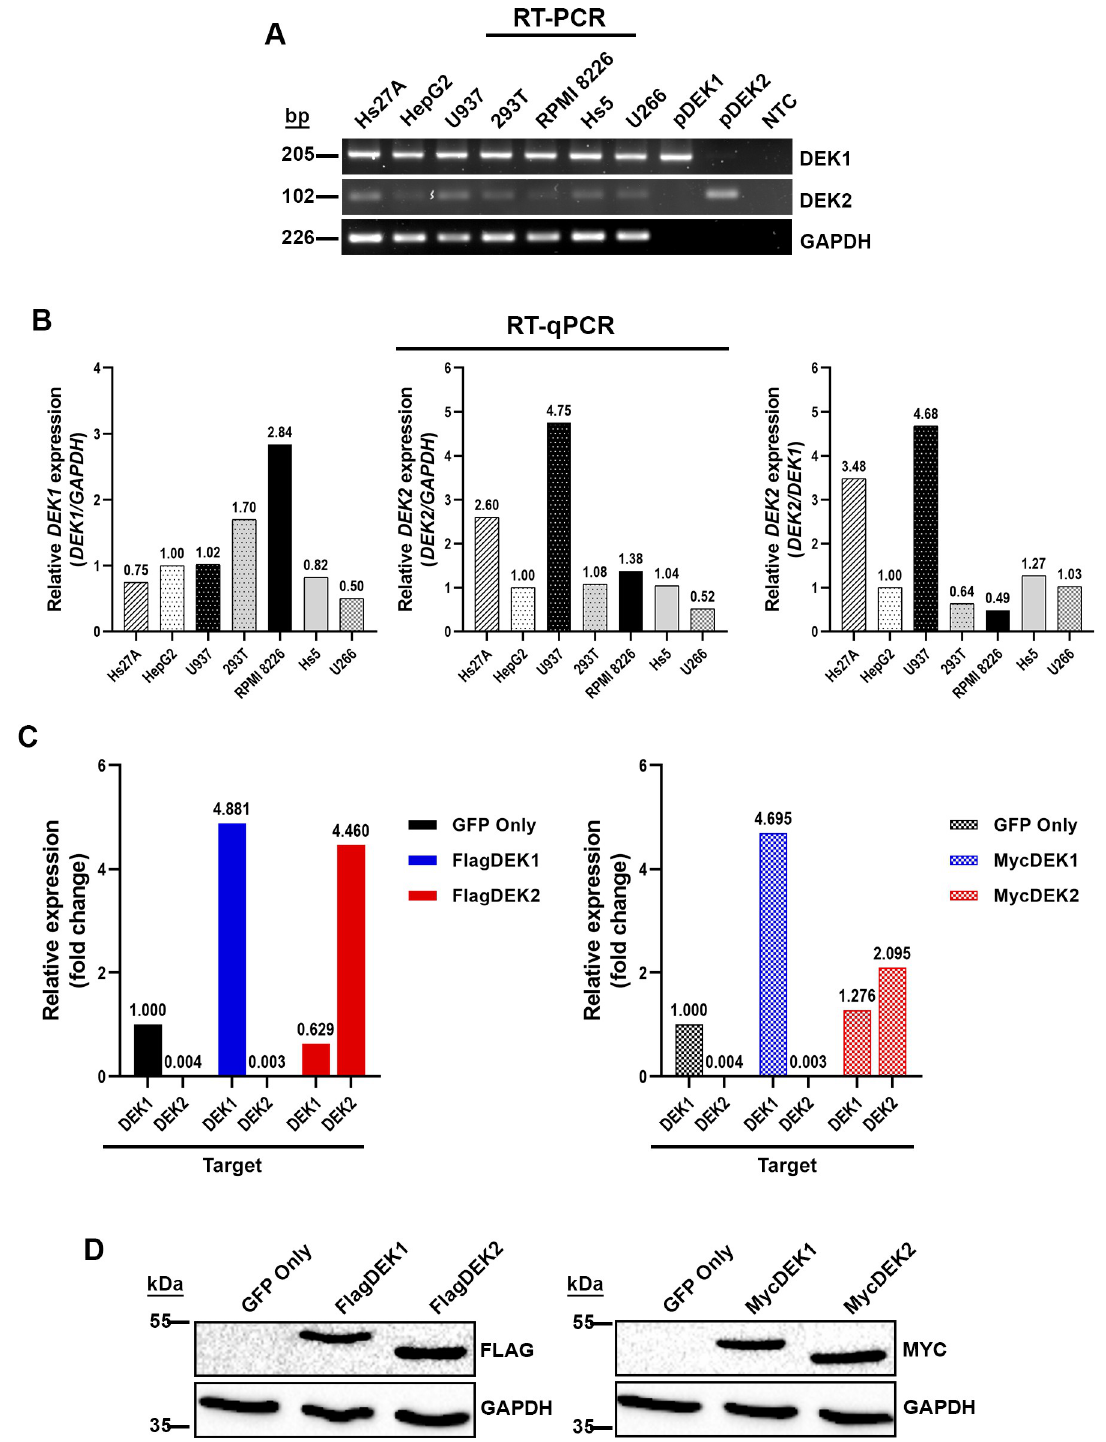
Fig 1. Expression level of DEK isoforms. (A) RT-PCR results show endogenous mRNA expression levels of each DEK isoform in human cell lines. The same amount of RNA and cDNA was analyzed for each sample by using primers specific to either DEK1 or DEK2 mRNA. GAPDH analysis was performed for the normalization. (B) RT-qPCR analyses of the same cell lines that were shown in the upper panel. HepG2 cells were used as a calibrator in these analyses. DEK1 and DEK2 expression that was normalized with GAPDH (left and middle panel) or DEK2 expression that was normalized with DEK1 (right panel) were shown. (C) The expression level of DEK1 and DEK2 in HS-27A cell lines that overexpress Flag (left panel) or Myc (right panel) tagged DEK isoforms was analyzed by RT-qPCR. The